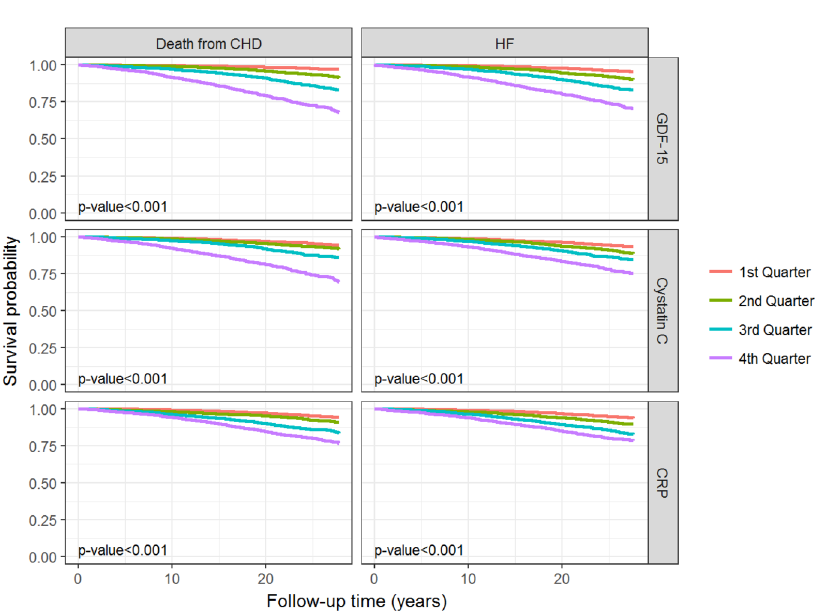
Fig 1. Survival curves for the endpoints death from CHD and incidence of HF. Survival curves for the endpoints death from CHD and incidence of HF according to the biomarker quarters. The p-value shown is for the logrank test.